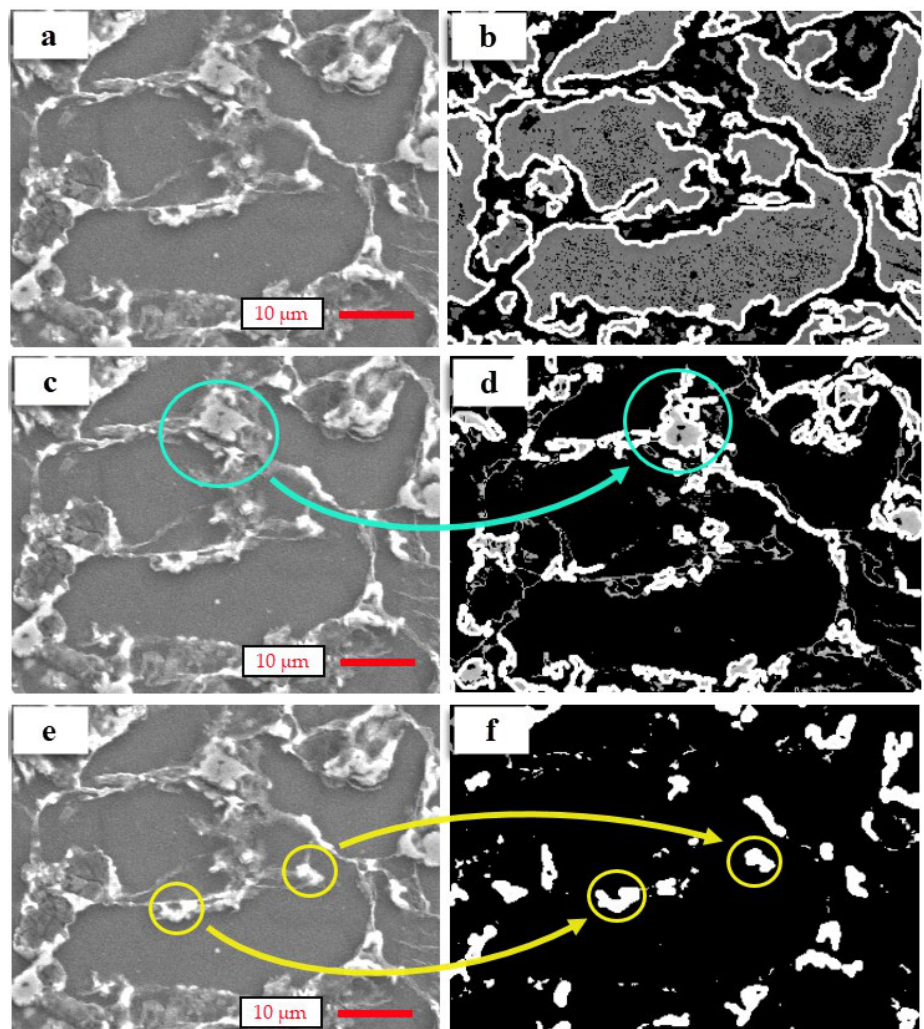
on the proposed method. The determined grains are indicated in Figure 4b; the grains are grey-coloured and the borders of the grains are white-coloured. The grain boundaries are black-coloured. In the processed image for determining Mg 17 Al 12 phases (Figure 4d), grains and Mg 2 Sn phases are black-coloured and Mg 17 Al 12 phases are white-coloured (see the areas in Figure 4b,d surrounded with blue circles). Finally, in Figure 4f, grains and Mg 17 Al 12 phases are black-coloured and Mg 2 Sn phases are white-coloured (see the areas in Figure 4e,f surrounded with yellow circles).